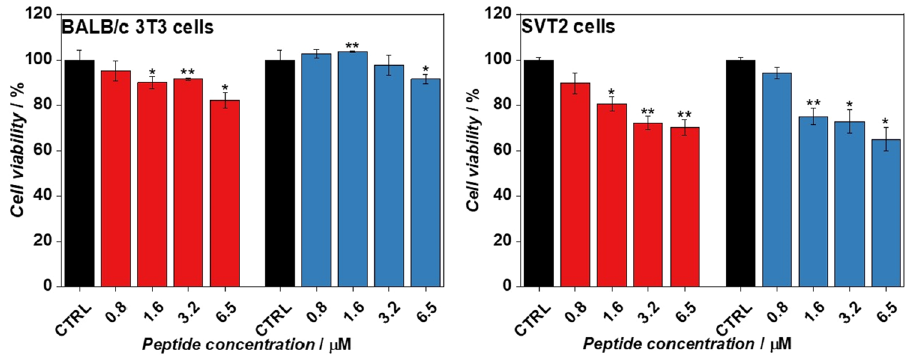
Figure 8. Effects of g-LL-III and LL-III on normal (BALB/C 3T3) and transformed (SVT2) murine fibroblasts. BALB/C 3T3 and SVT2 were grown in the presence of two-fold dilutions of g-LL-III and LL-III for 24